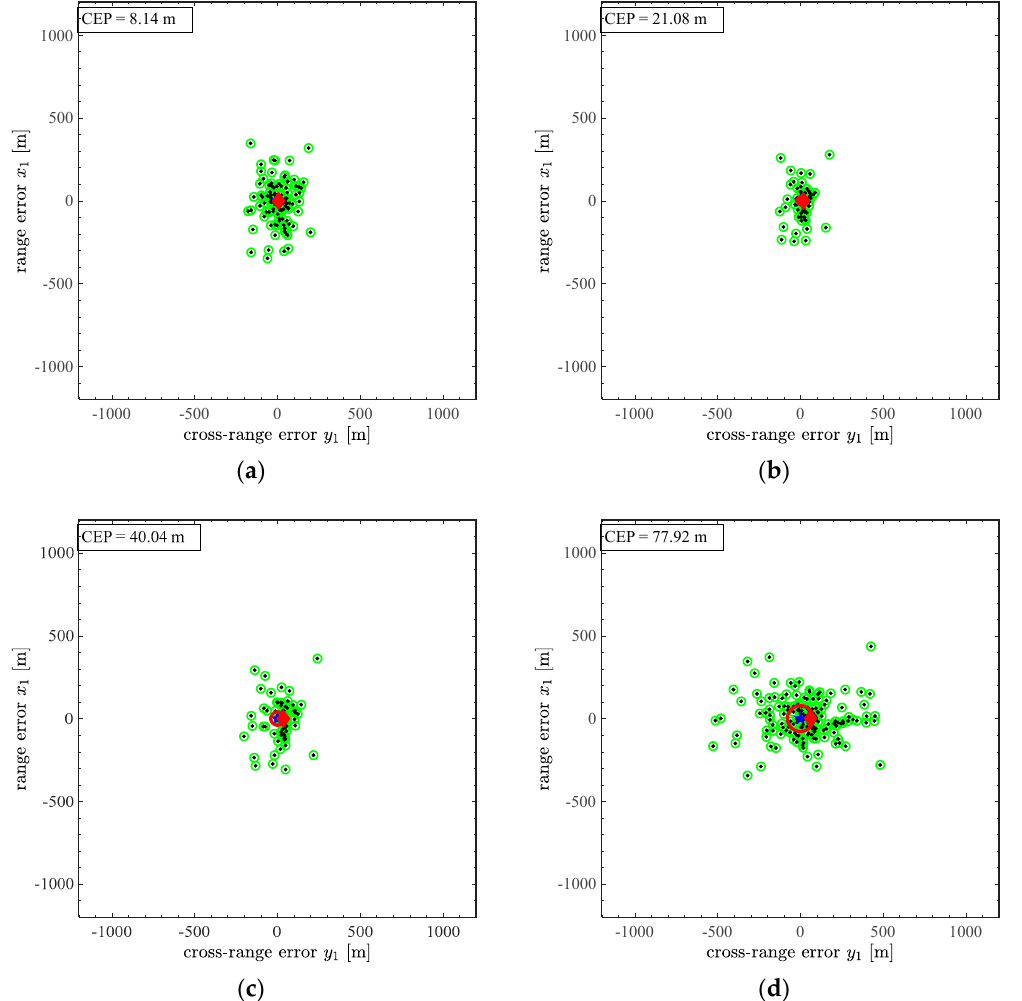
Figure 22. Hitting patterns for various nominal launch angles ( a ) Θ 0 = 20 ◦ ( b ) Θ 0 = 30 ◦ ( c ) Θ 0 = 40 ◦ ( d ) Θ = 50 ◦ (controlled with INS noise). Figure 22 . Hitting patterns for various nominal launch angles (a) 𝛩 (cid:2868) = 20° (b) 𝛩 (cid:2868) = 30° (c) 𝛩 (cid:2868) = 40° (d) 0 𝛩 (cid:2868) = 50° (controlled with INS noise)